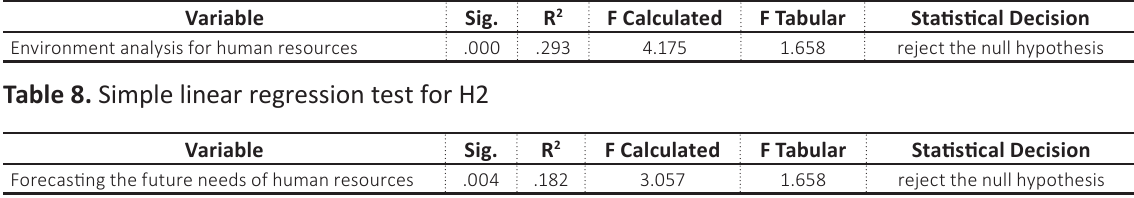
Table 7. Simple linear regression test for H1